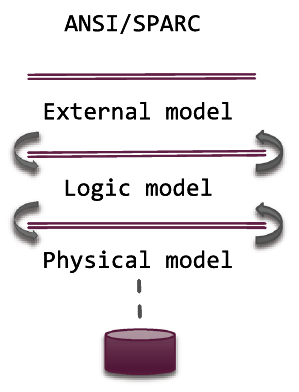
Fig. 3 ANSI-SPARC DBMS architecture